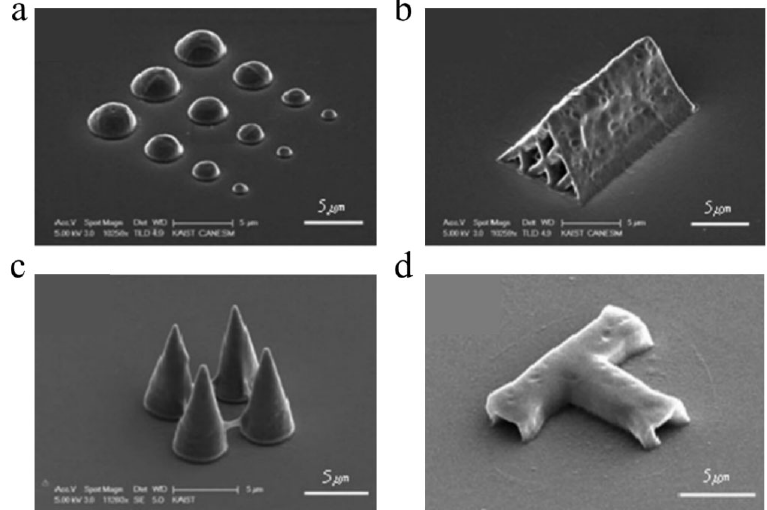
Fig. 25 Two-photon absorption fabrication of SiC ceramic micro–nano devices: (a) mirco-hemispheres; (b) micro-channels; (c) micro-cones; (d) microscale micro-channels. Reproduced with permission from Ref. [77], © The Royal Society of Chemistry